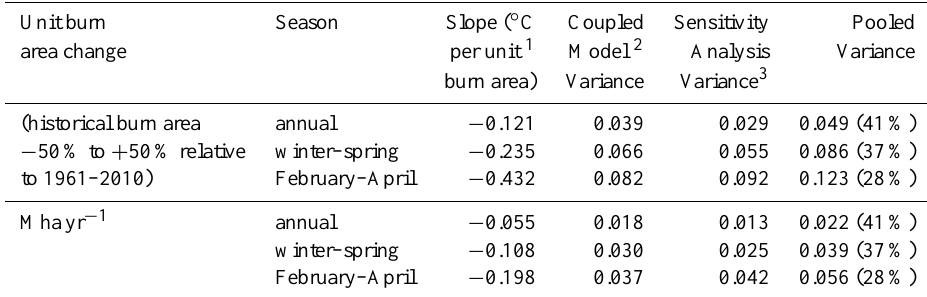
Table 4. Relationships between burn area and